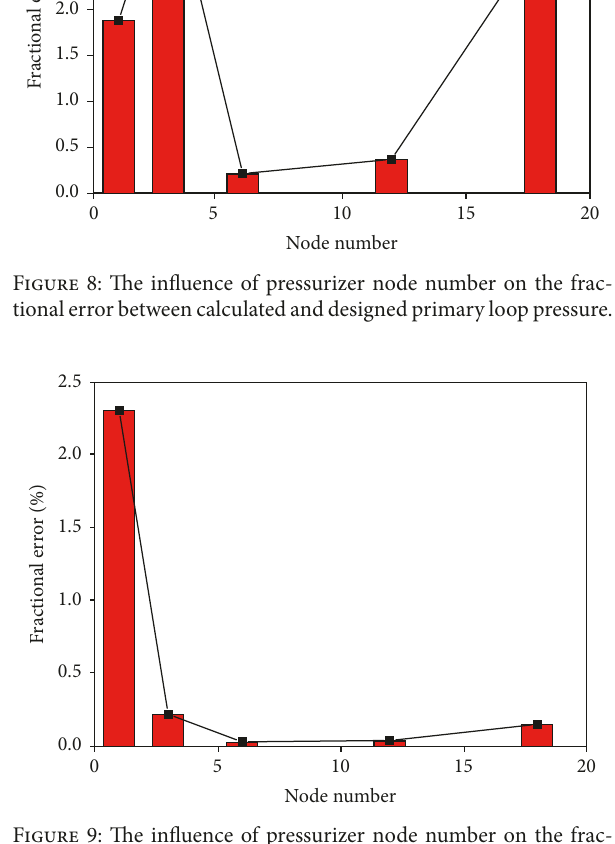
Figure 9: The influence of pressurizer node number on the frac- tional error between calculated and designed coolant temperature